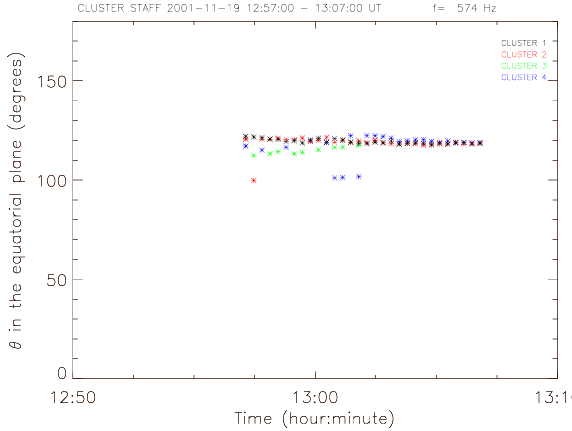
Fig. 4. Representation of the polar angle θ in the equatorial plane given by the ray tracing software as a function of time (it is the same time interval as Fig. 3) for each SC at